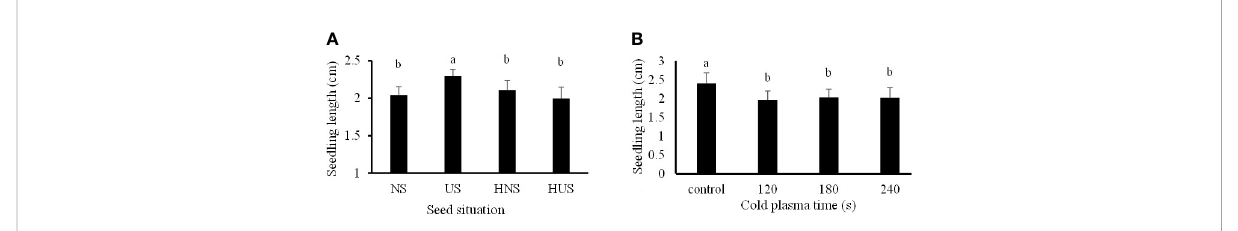
FIGURE 6 The effect of seed situation (A) and cold plasma exposure time (B) on seedling length of S. leriifolia genninated seeds. Normal seeds (NS), Uncovered seeds (US), Hydro-primed normal seeds (HNS) and Hydro-primed uncovered seeds (HUS). Values represent mean ± S.E. Different letters indicate signi fi cant differences at the 1% level according to the LSD